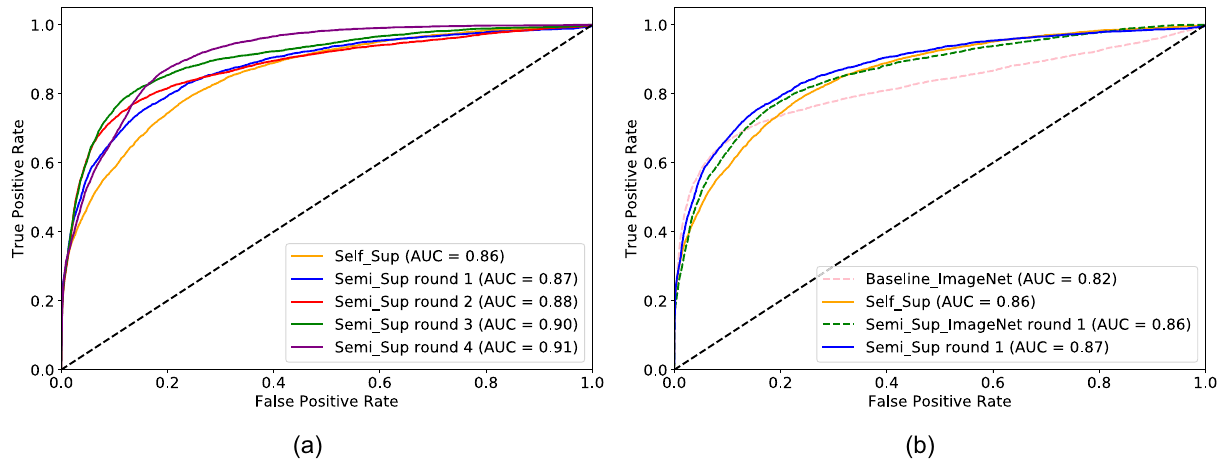
Figure 7. ROC curves of the baseline model with self-supervised initialization ( Self-sup ) and models fine-tuned via SSL on the large Training-300K dataset. ( a ) Performance comparison of four SSL rounds. ( b ) ROC curves of the baseline model with (continuous line) and without (dashed line) Self-sup initialization. Models trained with self-supervised initialization achieve higher performance with and without fine-tuning via SSL.